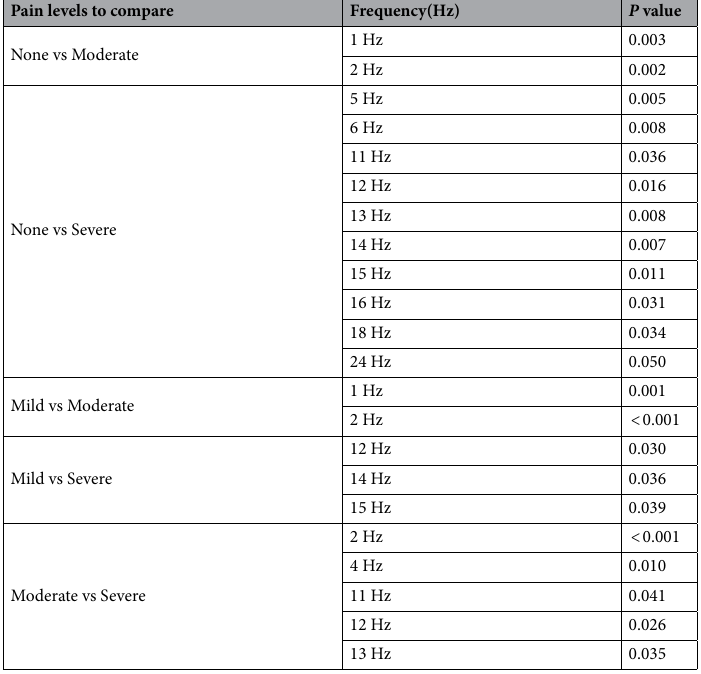
Table 2. Differences in brain wave amplitude of several frequency bands between pain levels. Amplitude power in each frequency was compared among quartile pain levels. The amplitude power of 10 frequency bands was significantly different between pain levels “None” and “Severe”. Similarly, 2 bands, 3 bands, 2 bands and 5 bands were significantly different between pain levels “None” and “Moderate”, “Mild” and “Severe”, “Mild” and “Moderate” and “Moderate” and “Severe”, respectively. There were no significant between “None” and “Mild”. Statistical analysis was undertaken using Student’s t-test and the resultant p values were corrected by Bonferroni correction to evaluate the significance.